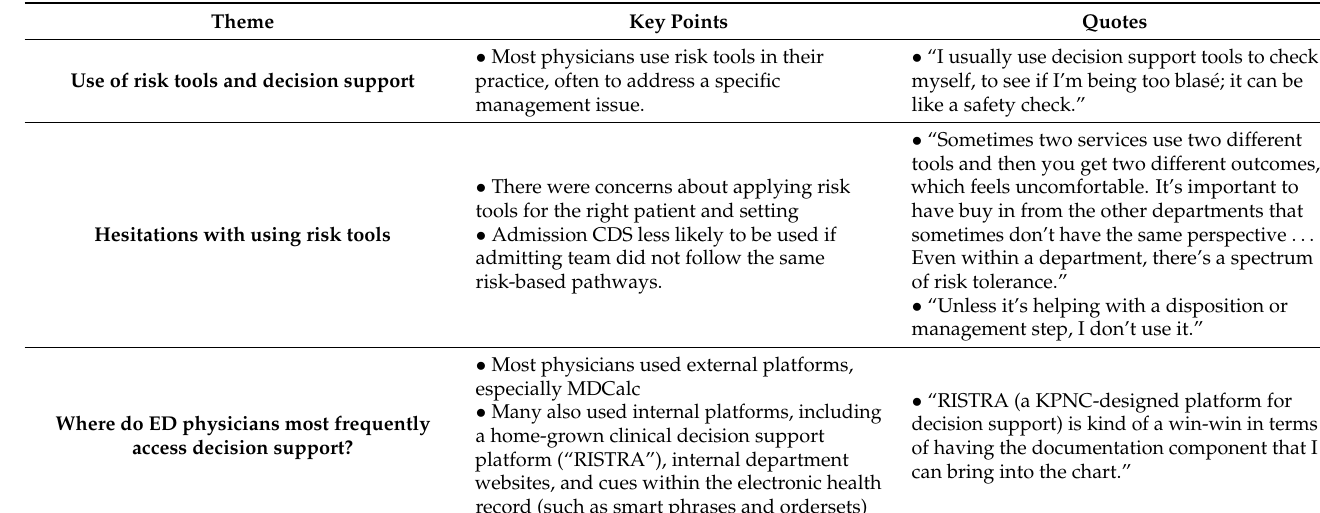
Table 1. Themes and representative quotes from qualitative interviews related to general use of risk prediction tools and CDS in clinical practice in the